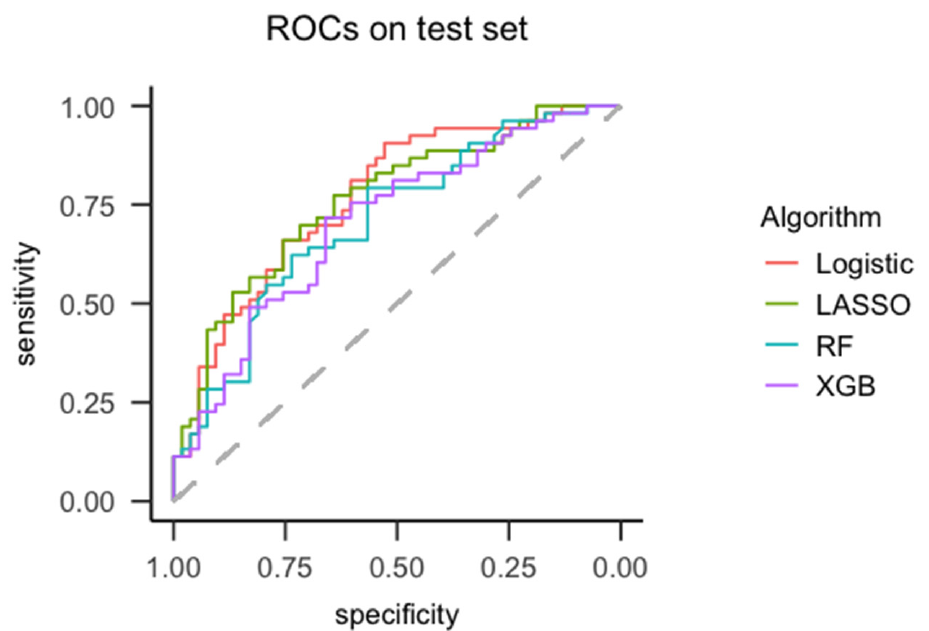
Figure 1. Receiver-operating characteristic (ROC) curves of algorithms tested on test set ( N = 106). Abbreviations: RF = Random forest, Logistic = logistic regression, XGB = Extreme gradient boosting, LASSO = least absolute shrinkage and selection operator.